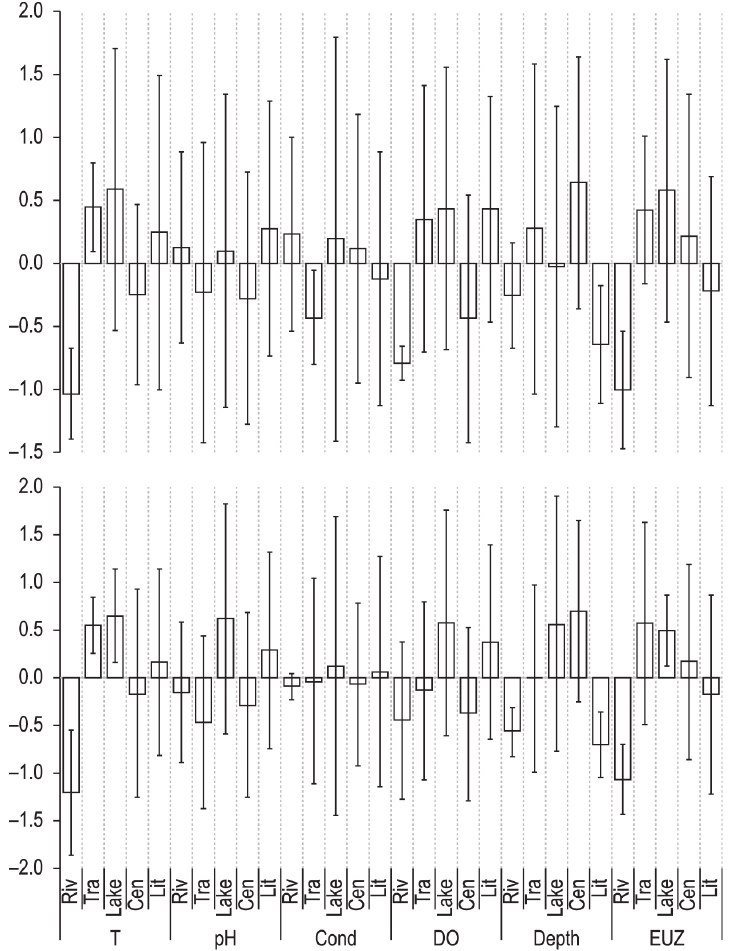
Figure 5. A bargraph presenting the average z scores by season (the superior refers to the wet season and the inferior to the dry season) considering the longitudinal and transversal gradients: riverine (Riv), transitional (Tra) and lacustrine (Lake) zones; central (Cen) and littoral (Lit) regions. The variables recorded here are: temperature (T), pH, electric condutance (Cond), dissolved oxygen (DO), depth and euphotic zone (EUZ). Errors bars represent the standard deviation in relation to the scores